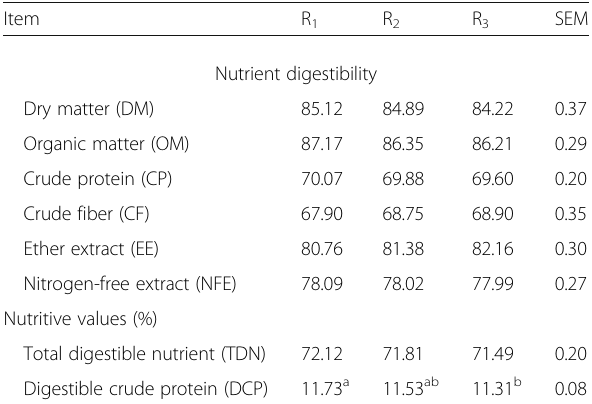
Table 3 Digestion coefficients and nutritive values of the experimental